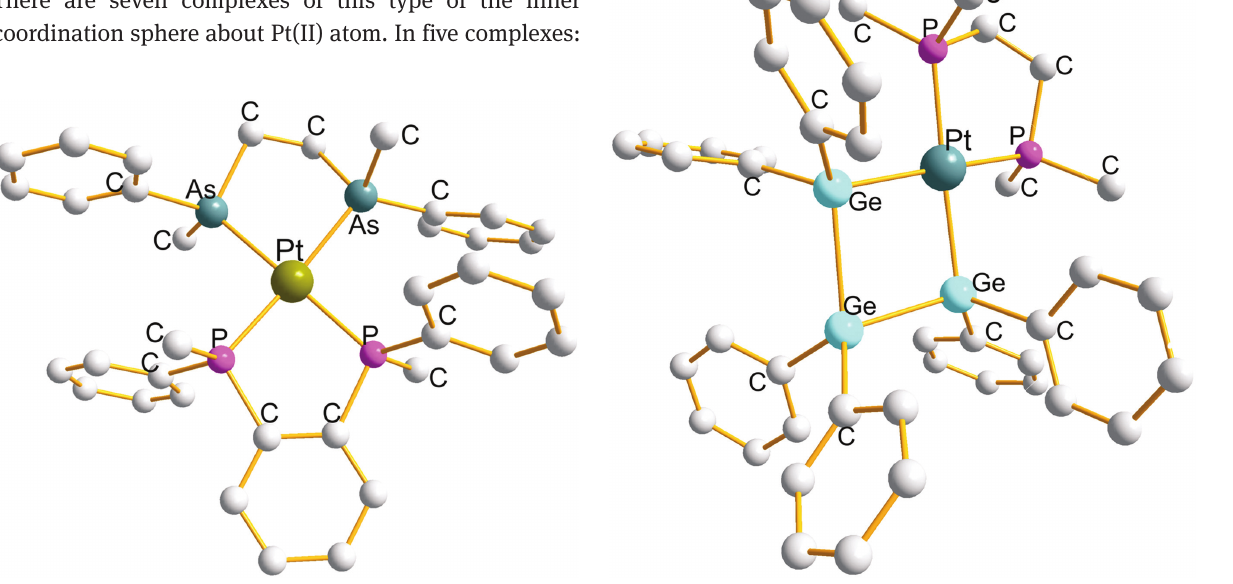
H )P(Me)(Ph)}{η 2 -(Ph) 6 4